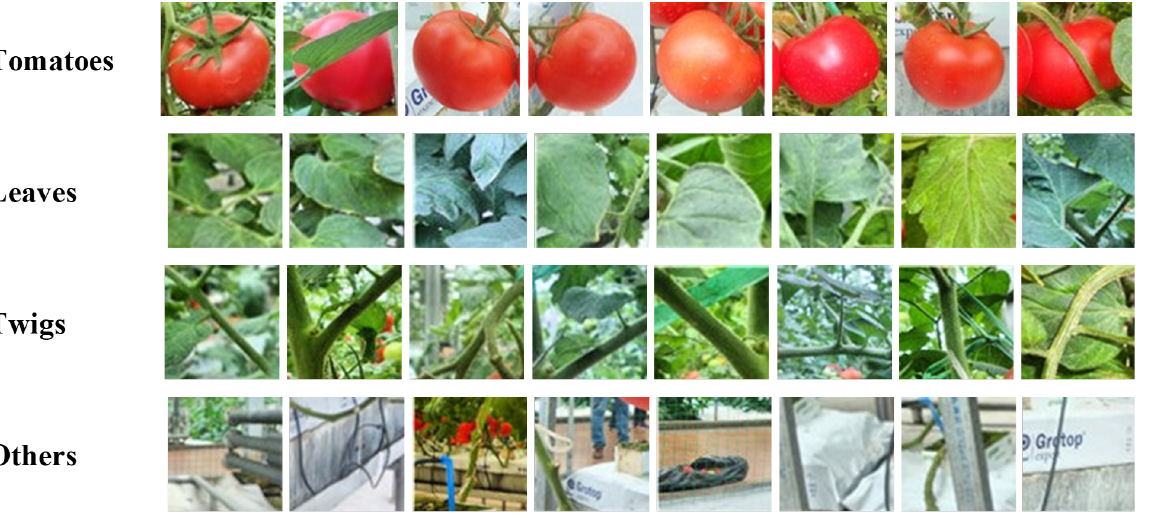
Figure 5. Examples from the dataset. Top row: tomato samples; lower row: background including leaves, stems, and other